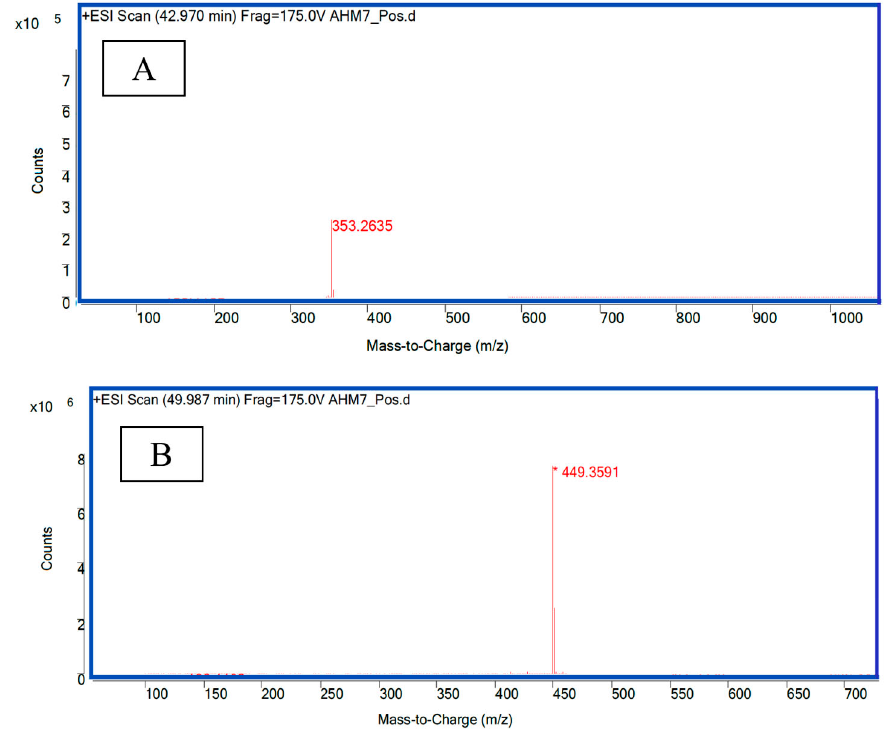
Fig. 2. LC-MS/MS chromatograms of: A. cryptochlorogenic acid (molecular weight, 353.26), B. astragalin (molecular weight,